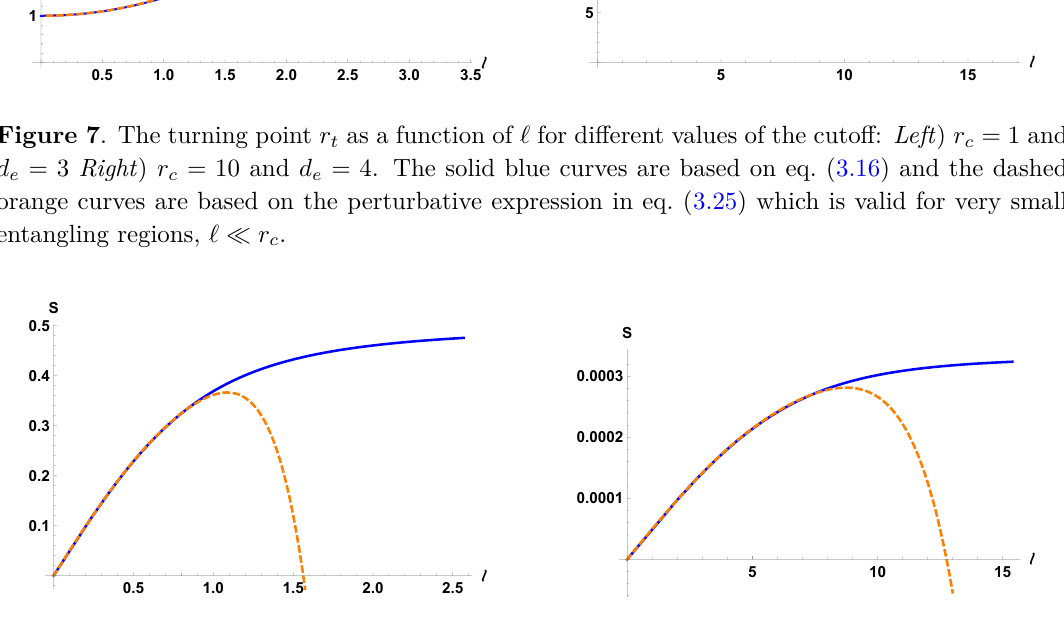
, and the solid blue curves are numerical c